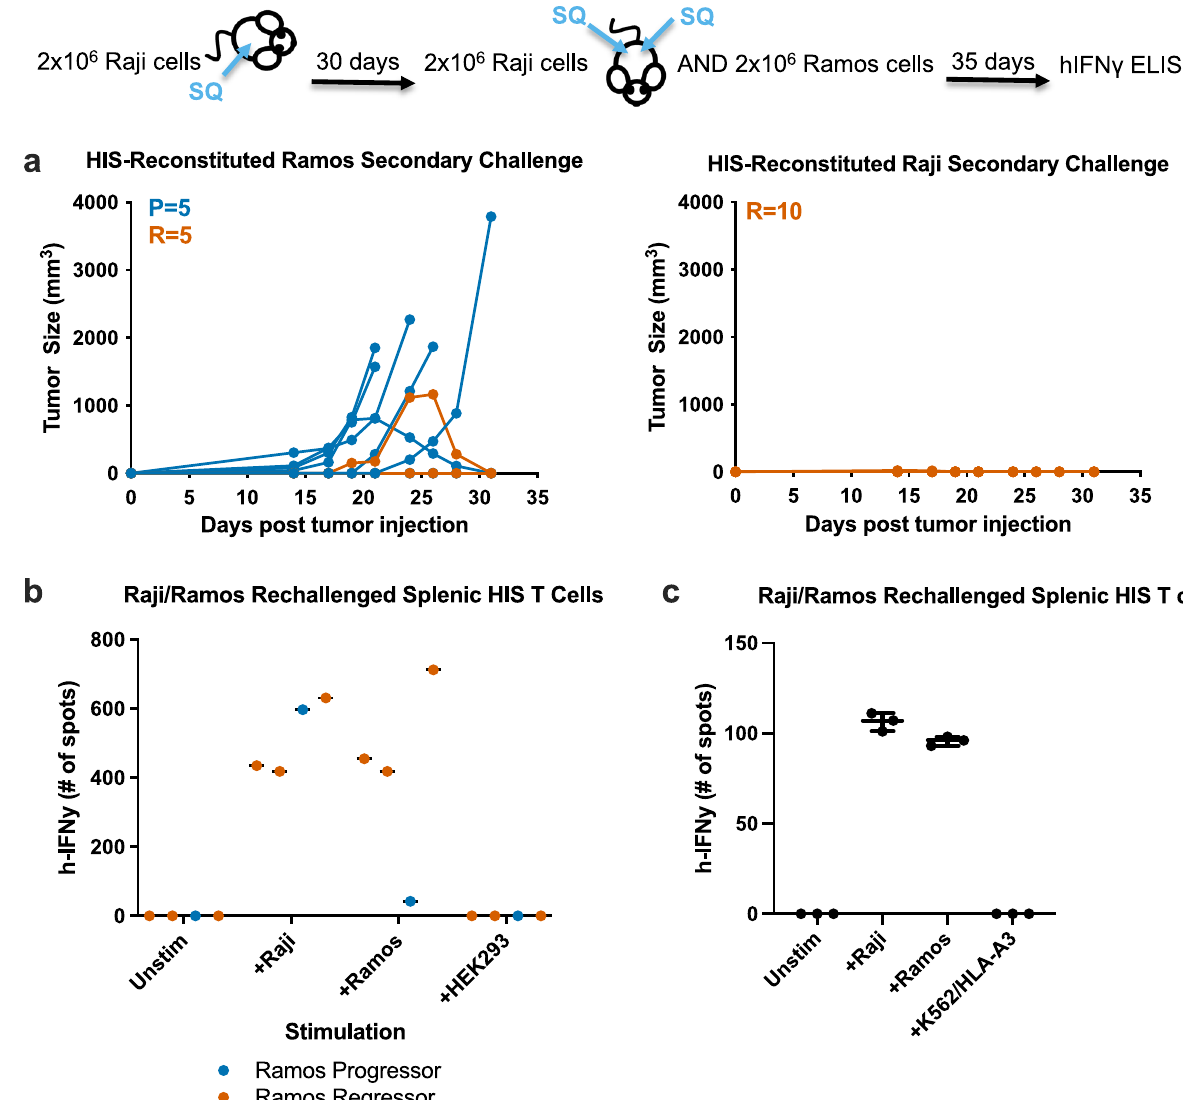
Fig. 3 Tumor-speci fi c T-cell memory elicited by Raji implantation. a Human immune system (HIS) reconstituted mice were implanted subcutaneously into the right fl ank with Raji tumor cells. 30 days after tumor clearance, mice ( n = 10) were rechallenged with Raji in the right fl ank and Ramos in the left fl ank. The number of mice with tumor progression (P; blue) or regressor (R; orange) is shown. b ELISpot data comparing HIS splenic T cells from Ramos progressor ( n = 1) and Ramos regressor ( n = 3) mice. HIS splenic T cells were co-cultured alone (unstimulated), Raji, Ramos or HEK293. c ELISpot data of T cells isolated from Raji-experienced mouse that elicited Ramos regression. T cells were co-cultured alone (unstimulated) or with Raji, Ramos, or K562 cells expressing HLA-A3. Mean values with SD are indicated. Error bars are equivalent